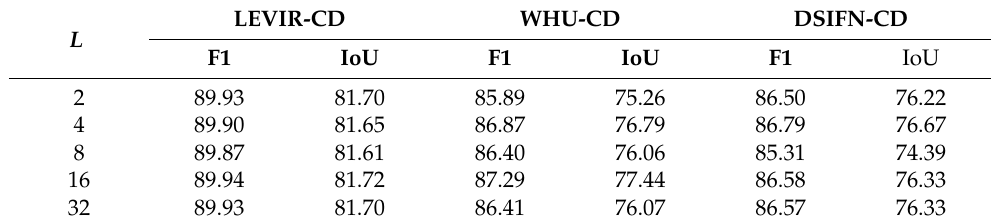
Table 3. The experimental results of parameter analysis on tokens length. L